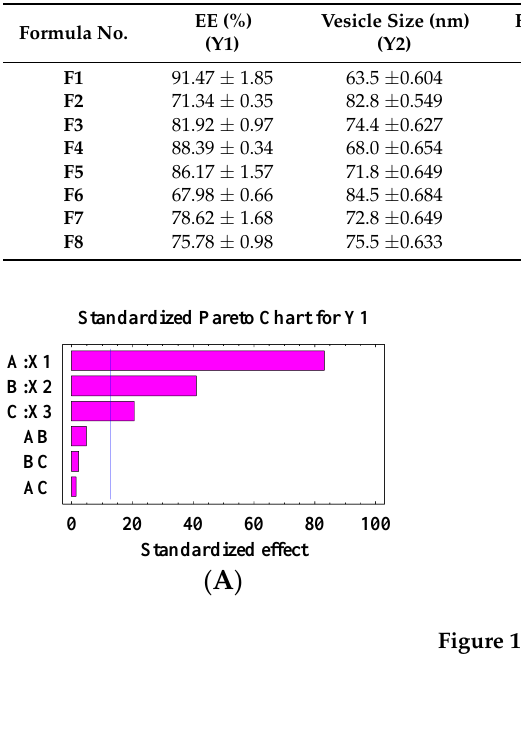
Table 3. Characterization of prepared MIC Transfersomes.